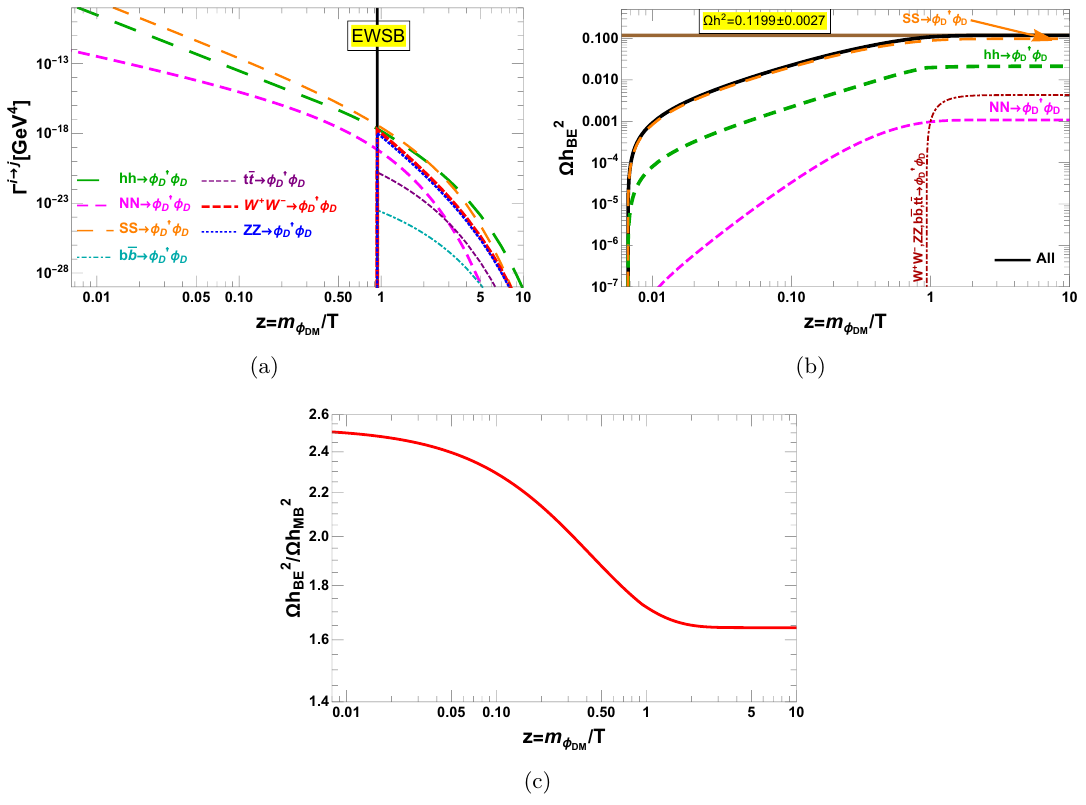
Figure 6 . The figures correspond to Scenario-2 . Figure 6(a) shows the relativistic reaction rates for different process corresponding to production of φ . Figure 6(b) shows the individual contributions D to the relic density, and the total relic density. The brown horizontal line represents the present experimentally measured relic density [54]. Figure 6(c) shows the relative enhancement in the relic density with respect to Maxwell-Boltzmann